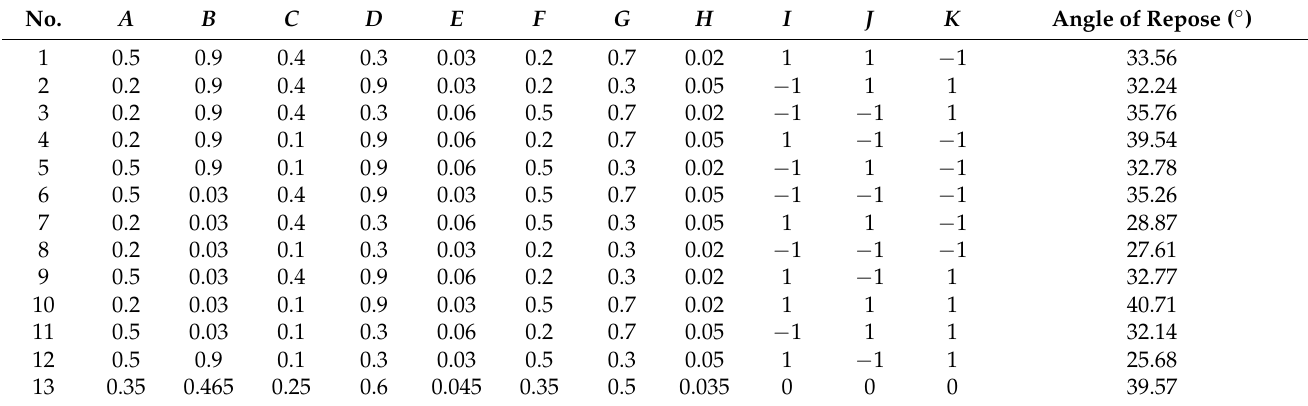
Table 3. The schemes and results of the simulation parameters with the Plackett-Burman design.